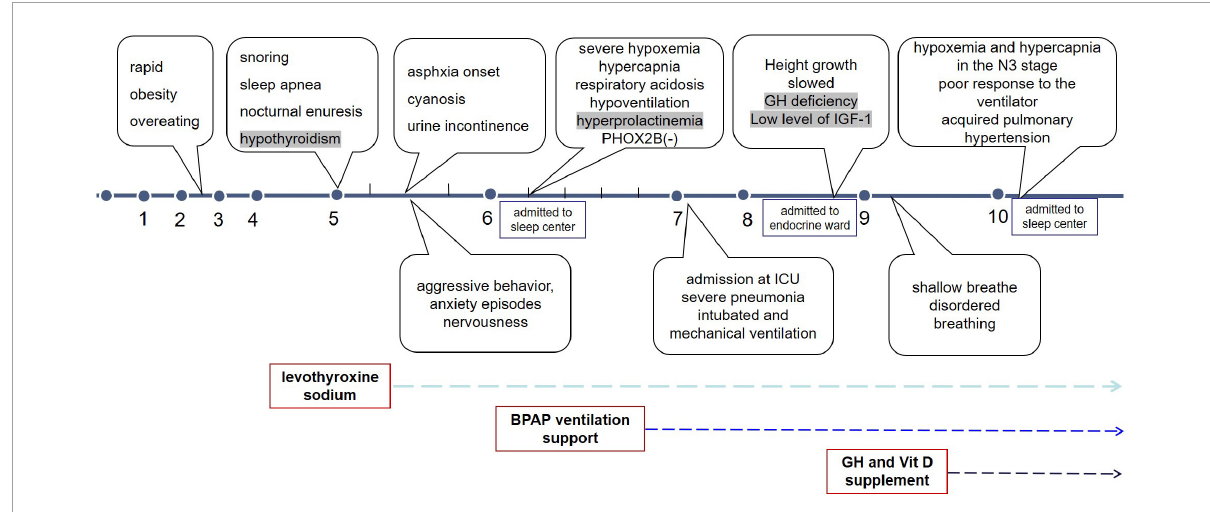
FIGURE3 Timeline of symptoms and